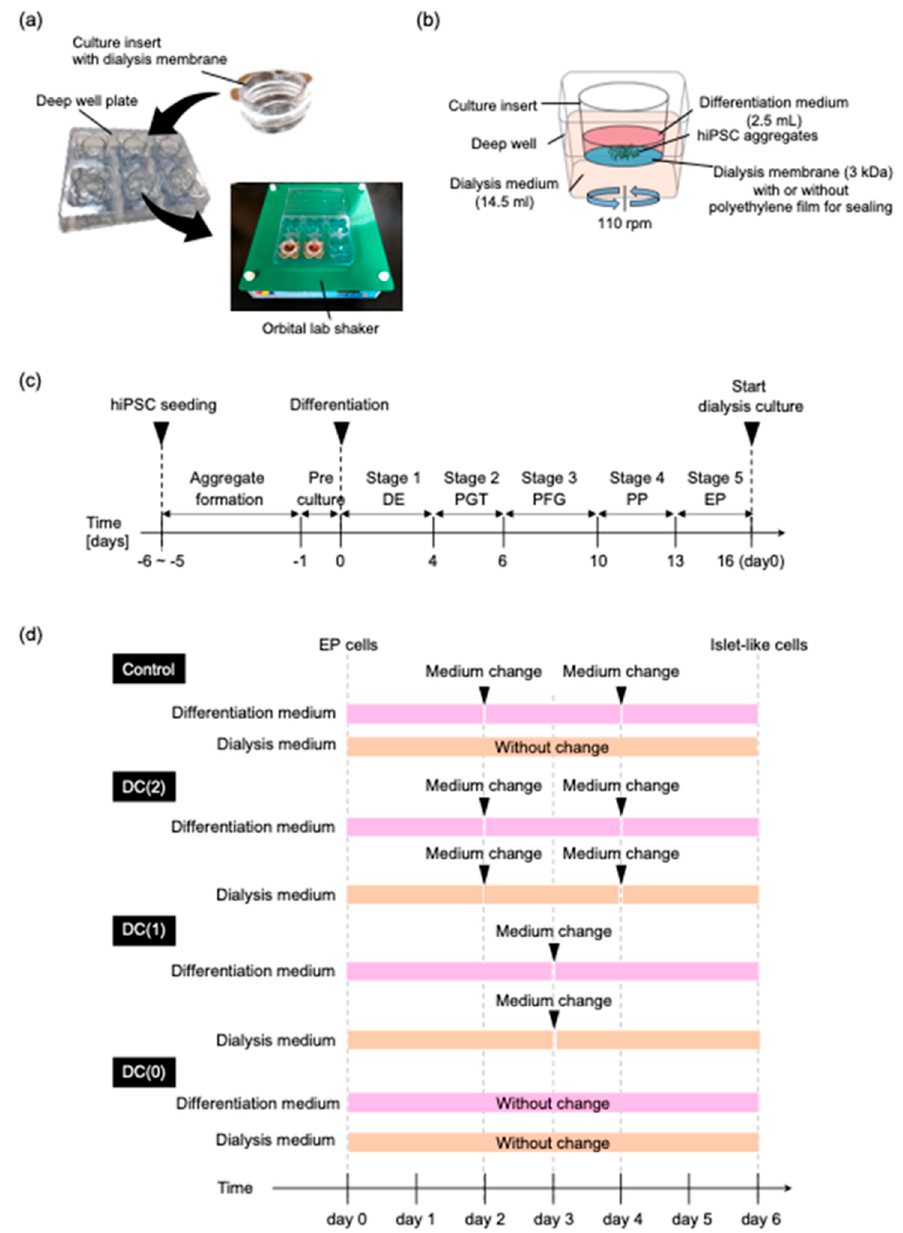
Figure 1. Dialysis suspension culture plate was used for the differentiation of EP cells to islet-like cells. ( a ) Photograph of the dialysis suspension culture plate. ( b ) Schematic diagram of dialysis suspension culture plate for the differentiation of endocrine progenitor cells into islet-like cells. ( c ) Overview of the differentiation schedule for preparation of EP cells. ( d ) Schedule of differentiation of EP cells into islet-like cells, and medium change interval of each culture’s conditions in Stage 6.